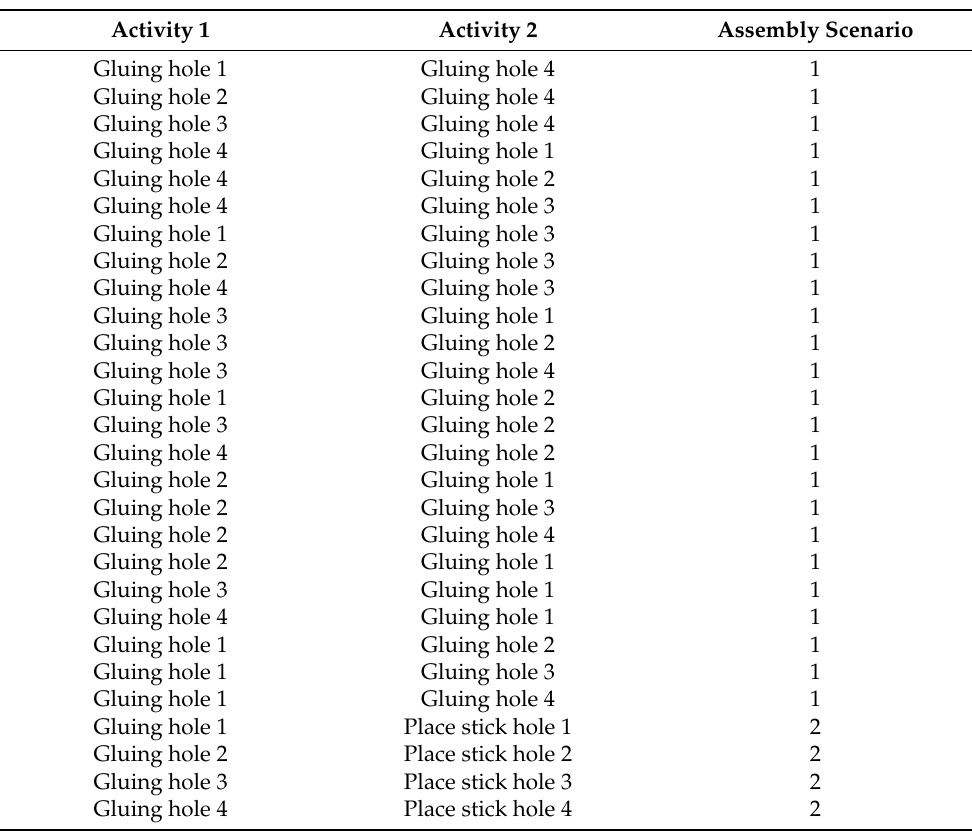
Table 7. Assembly Scenarios.